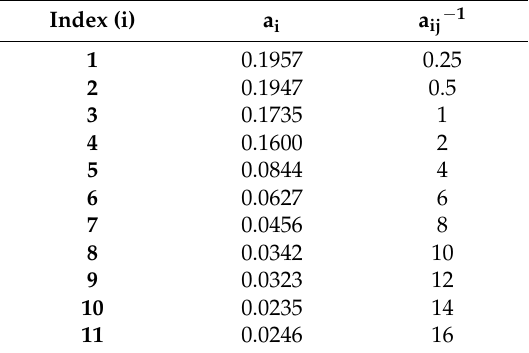
Table 5. Coefficients of Kowalik’s Function (F15).